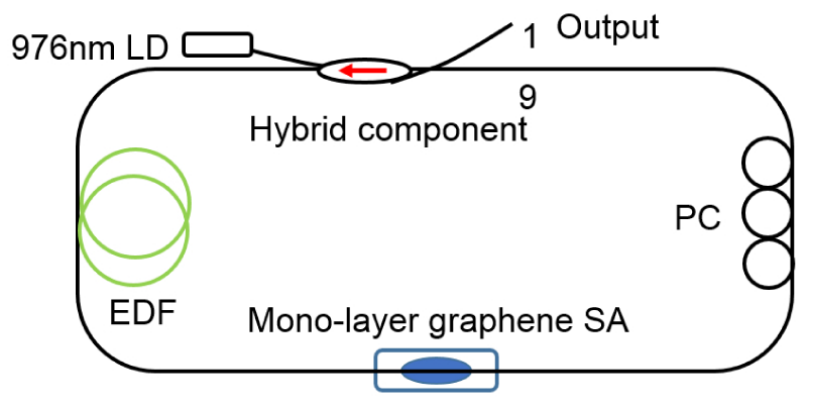
Figure 5. Schematic illustration Er-doped fiber laser ring-cavity comprising a single layer graphene SA on the SPF. LD: laser diode; EDF: erbium-doped fiber; PC: polarization controller; hybrid component: an integrated wavelength-division multiplexer and isolator. Reproduced with permission [128]. Copyright 2015, The Optical Society of America.